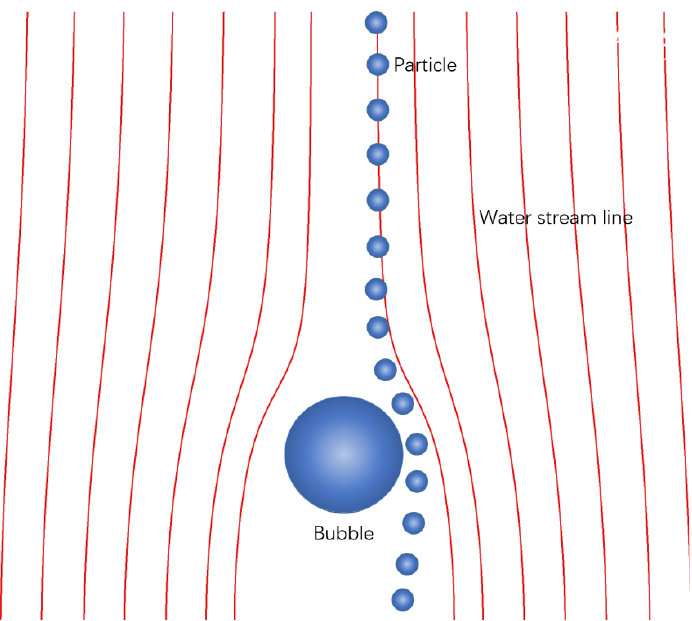
Figure 1. Bubble–particle interaction process with water streamlines from computational fluid dynamics (CFD) simulation in a frame of reference in which the bubble is stationary (Li 2019) [3].